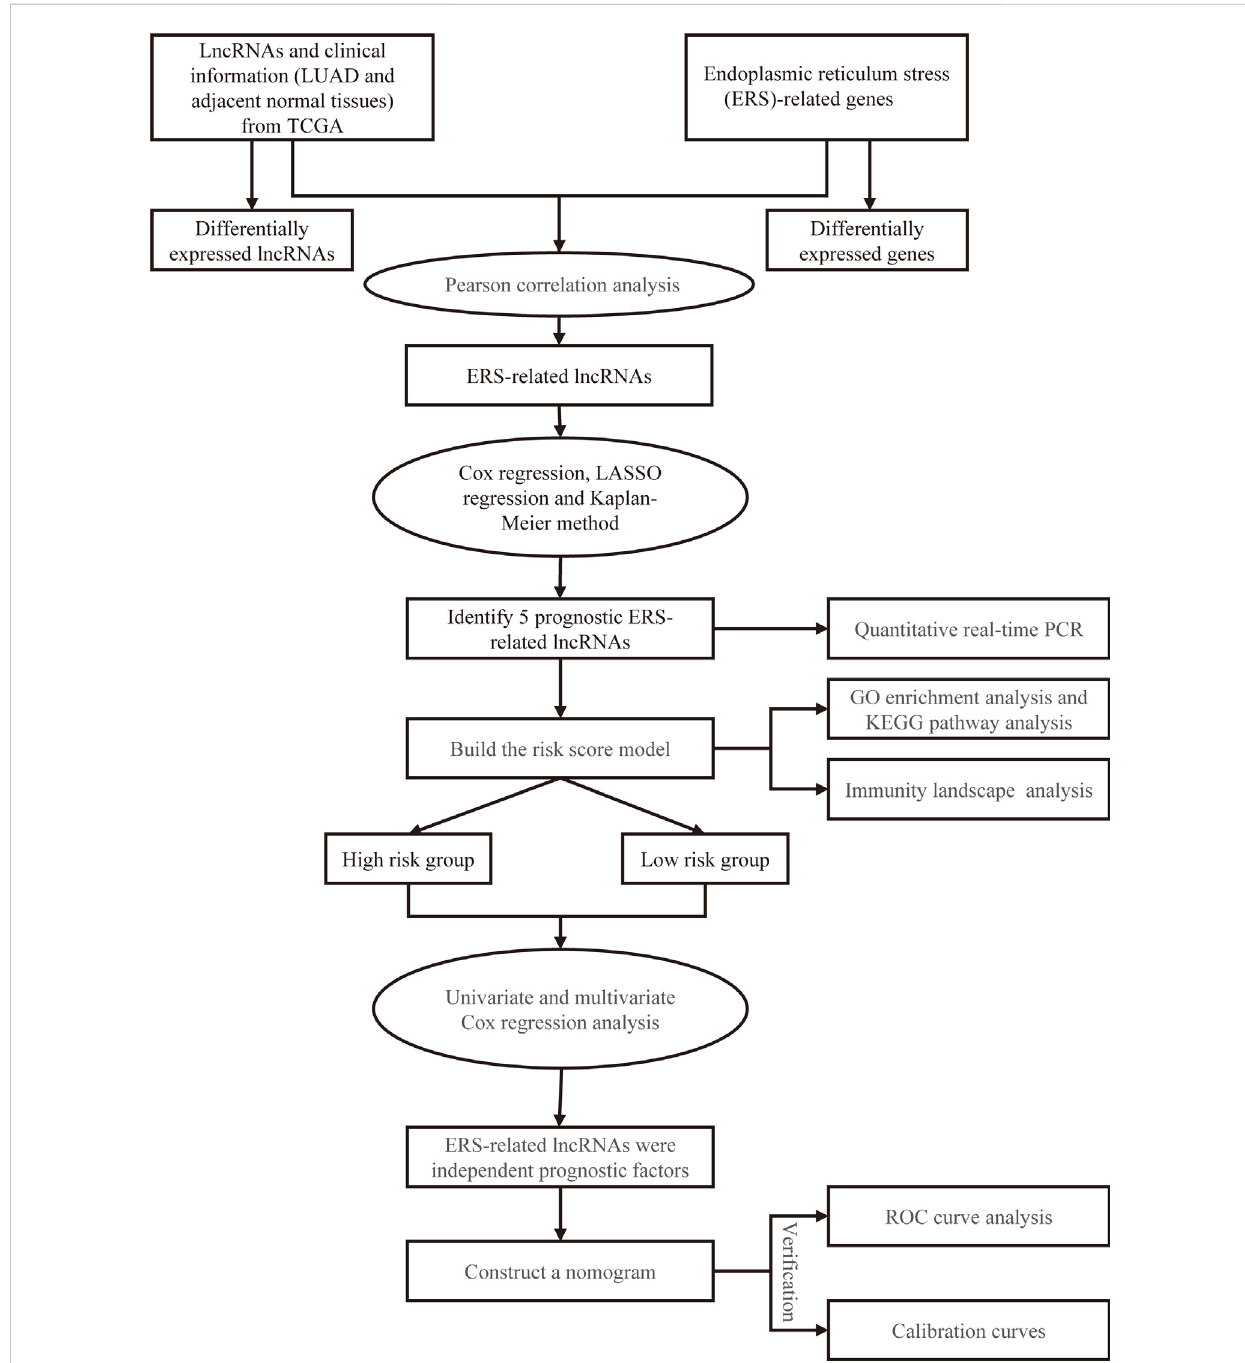
FIGURE 1 Flowchart of our design for the